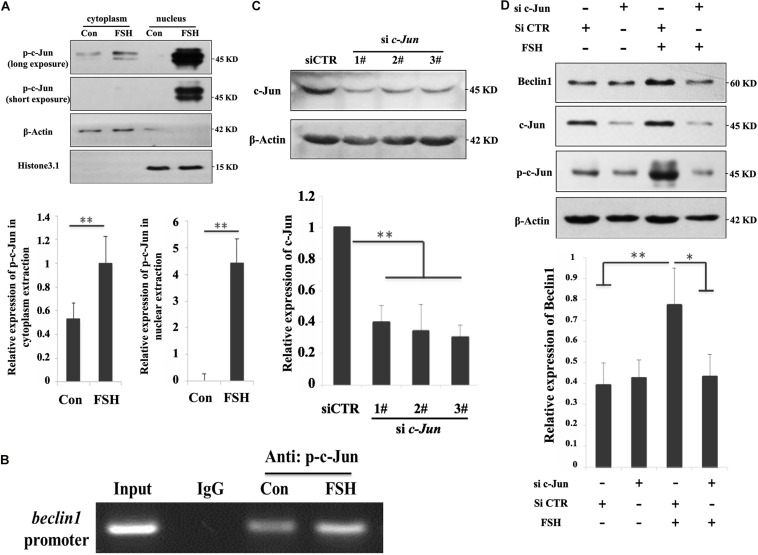
C-Jun was directly involved in beclin1 transcription in response to FSH treatment. (A) GC mass were cultured in DMEM/F12 medium containing 0.01 IU/mL FSH for 24 h, and nuclear and cytoplasmic fractions were prepared from granulosa cells and analyzed by western blotting using the indicated antibodies. Histone 3.1 and β-actin served as the fractionation and loading controls, respectively. ∗∗, P < 0.01 compared to the control group. (B) GC mass were cultured in DMEM/F12 medium containing 0.01 IU/mL FSH for 24 h, the cells were lysed, CHIP assays were performed, chromatin fragments were immunoprecipitated with antibodies against p-c-Jun antibody or normal rabbit IgG, and the beclin1 promoter was amplified by PCR. The graph of RT-PCR data represents the relative binding by p-c-Jun to the specified DNA-binding elements. (C) GC mass were transfected with c-Jun siRNAs (si c-Jun 1-3#) and control scramble siRNA (si-CTR) for 24 h and were then harvested and analyzed by immunoblotting with antibodies against c-Jun and actin. (D) GC mass were transfected with 3# c-Jun siRNA (si-c-Jun) and control scramble siRNA (si-CTR). At 20 h after transfection, the cells were treated with 0.01 IU/mL FSH for 24 h before harvesting. C-Jun, p-c-Jun, beclin1, and actin were detected in the whole cell lysates. ∗, p < 0.05; ∗∗, P < 0.01 compared to the control group.